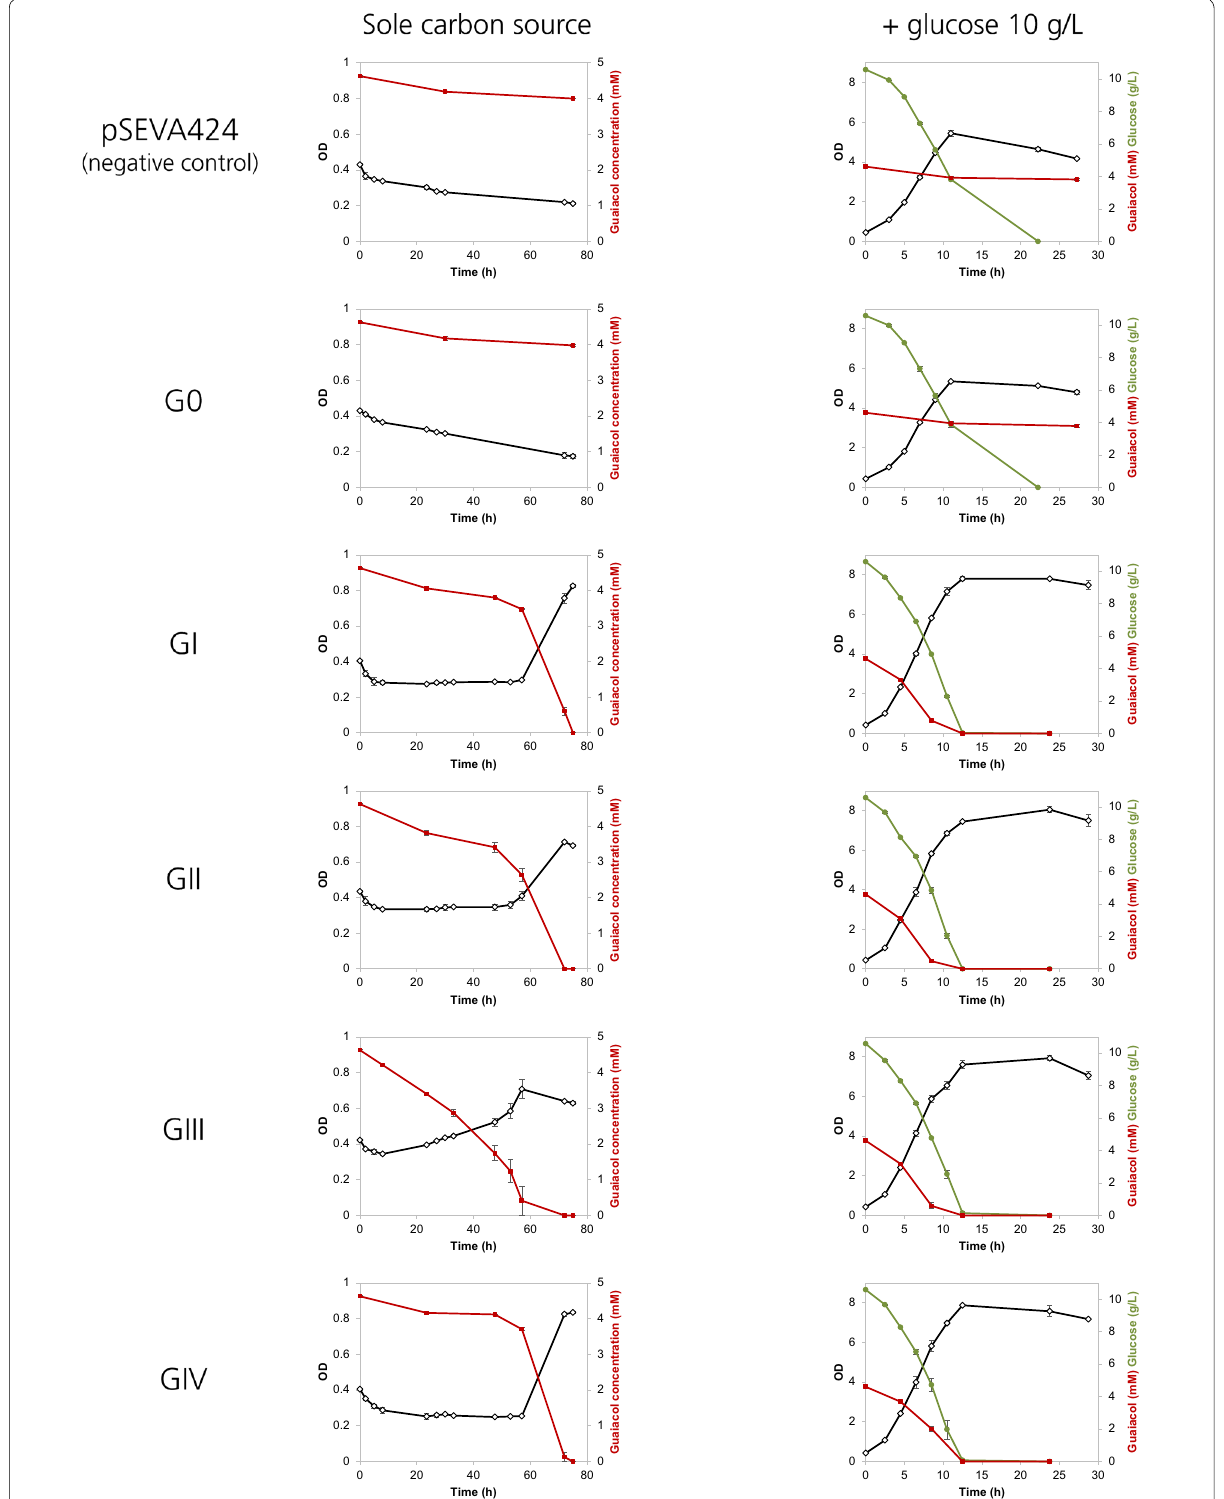
Fig. 4 Guaiacol assimilation experiments with the six strains used in this study in M9 mineral medium with guaiacol 5 mM as sole carbon source (left panels) and in the presence of glucose 10 g/L (right panels). OD 620 is shown in black, guaiacol concentration is shown in red and glucose concentration is shown in green. Vertical error bars represent standard